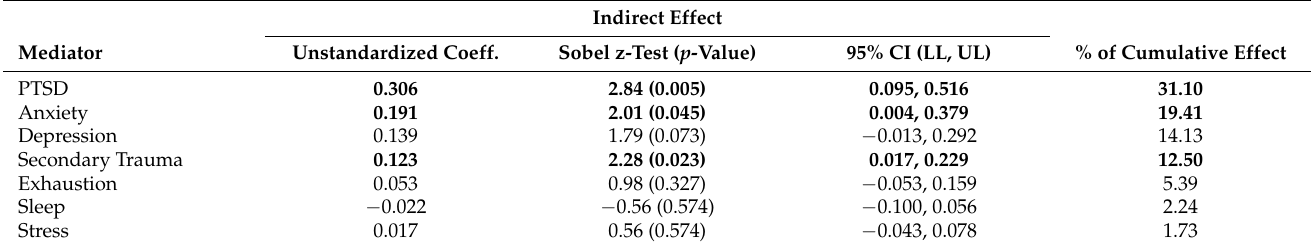
Summary of indirect effects of reported increased substance use on workplace cognitive